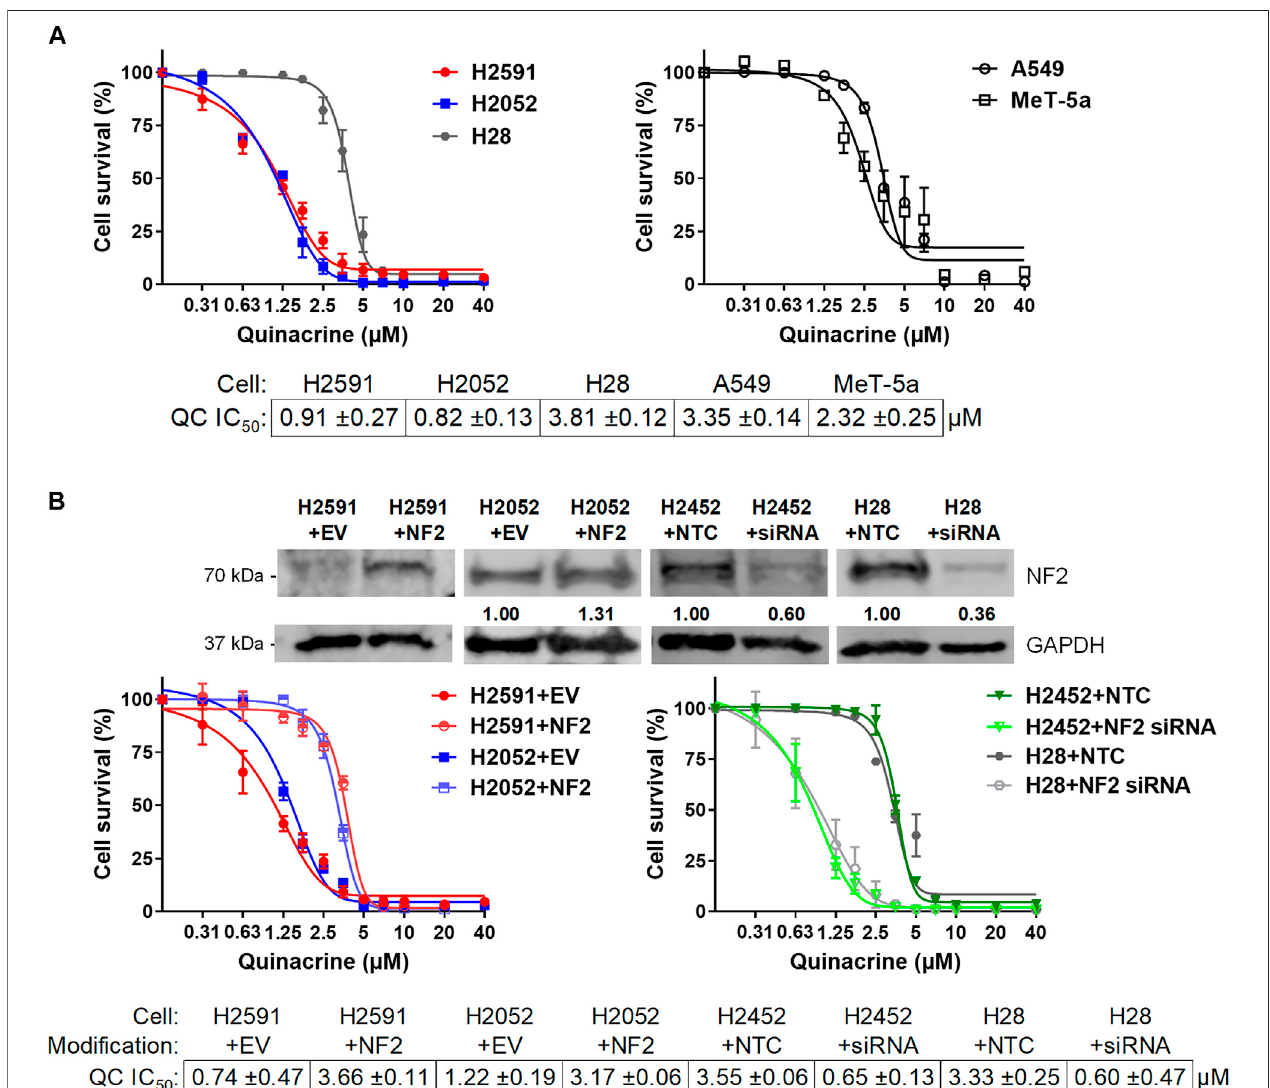
FIGURE 2 | Quinacrine response changes based on NF2 status. (A) Cell death assays with quinacrine in NF2-mutated H2591 and H2052 cells compared to H28 ( left ) andA549lungcancercellsandnon-malignantMeT-5Amesotheliumcells ( right ) ; (B) EctopicNF2expressionorNF2knockdowninNF2-mutatedorNF2-wildtype cells, respectively. Immunoblot validation of ectopic expression or knockdown was compared to cells with empty vector or non-targeting control transfections.